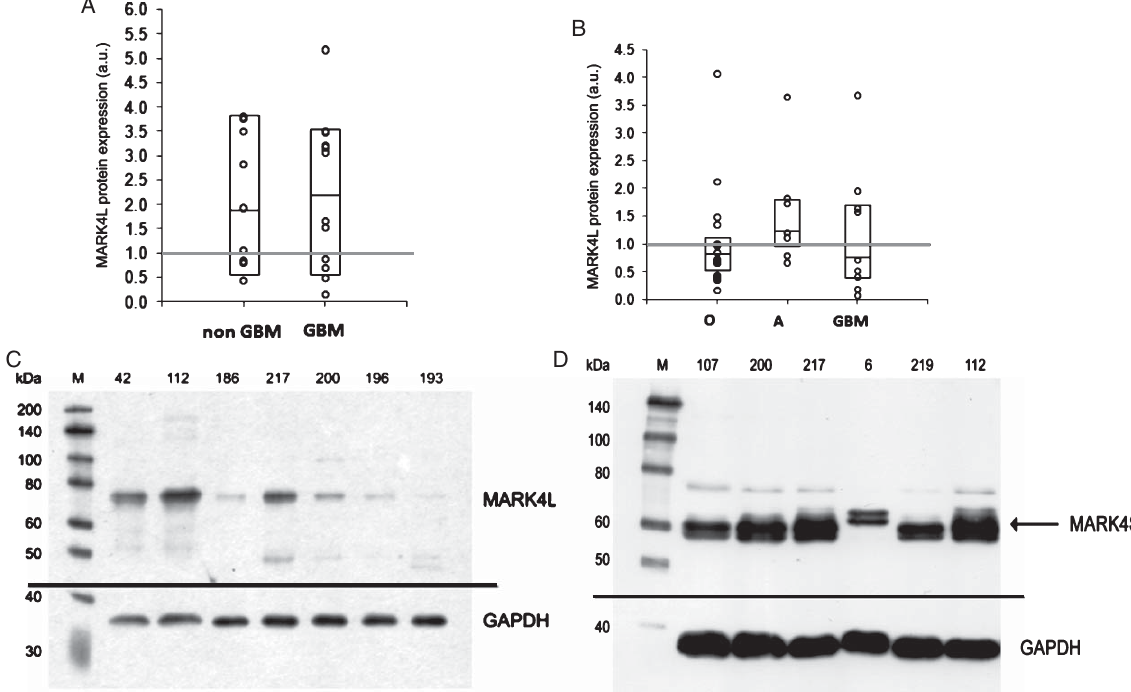
Fig. 2. Relative MARK4L protein expression measured by immunoblotting. (A) non GBM and GBM cell lines compared with NHNPCs (set as 1 and represented as a horizontal grey line). (B) O, A and GBM tissues compared with HNB (set as 1 and represented as a horizontal grey line). (C) Representative MARK4L immunoblot of O tissue samples (42, 112, 186, 217, 200, 196, 193). (D) Representative MARK4S immunoblot of O tissue samples (107, 200, 217, 6, 219, 112). The membrane was cut (black lines) after the blocking step and incubated with the appropriate antibodies. M, molecular weight ladders